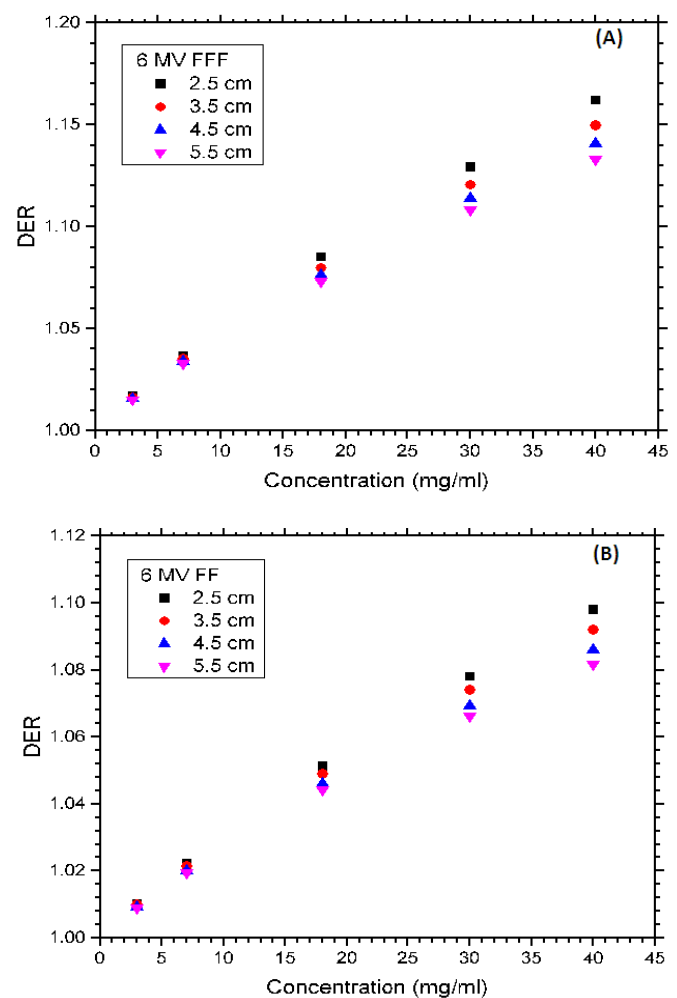
Figure 3. Relationship of the DER and Au NP concentrations, varying with different prostate sizes in the phantom using the 6 MV ( A ) FFF and ( B ) FF photon beams. Au NPs with concentrations equal to 3, 7, 18, 30, and 40 mg / mL were used. The DER was calculated as the ratio of the target dose with NP addition to the target dose without NP addition [1].